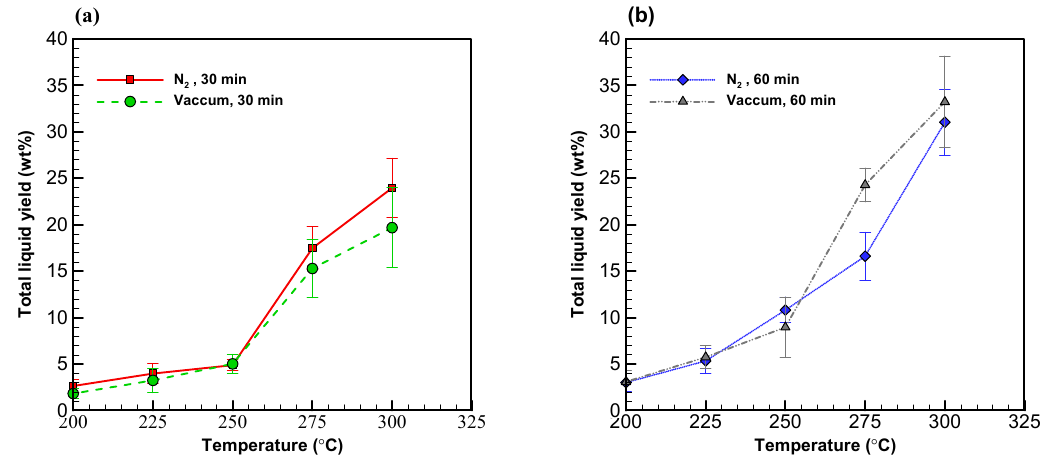
Figure 3. Profiles of liquid yields from wood sawdust torrefaction for ( a ) 30 min and ( b ) 60 min.